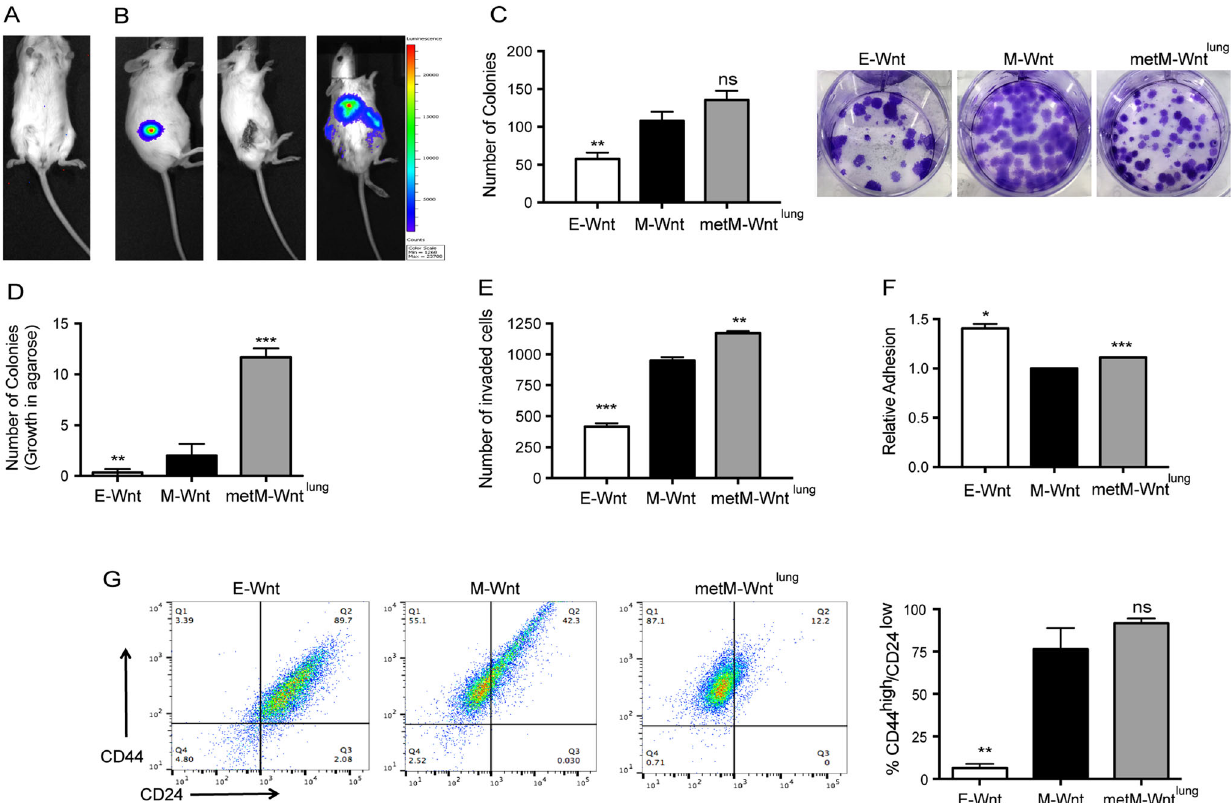
Fig. 1 Generation and in vitro characterization of metM-Wnt lung cells. a Representative IVIS image of C57BL/6 mice injected via tail vein with GFP-Luciferase expressing M-Wnt cells, showing no resulting metastasis. b Representative IVIS image of SCID mice injected with GFP- Luciferase expressing M-Wnt tumor brei, following survival surgery to remove tumor and resultant metastases in lung (left to right). c Colony formation assay of E-Wnt, M-Wnt, and metM-Wnt lung cells and d colony formation in soft agarose. e Matrigel invasion assay and f adhesion assay of E-Wnt, M-Wnt and metM-Wnt lung cells. g Representative fl ow cytometry analysis of E-Wnt, M-Wnt and metM-Wnt lung cells stained with antibodies speci fi c for CD44 ( y -axis) and CD24 ( x -axis), quanti fi ed in right-hand graph. All in vitro experiments are inclusive of three independent experiments. * p < 0.05, ** p < 0.01, *** p < 0.001, ns non-signi fi cant, as compared with